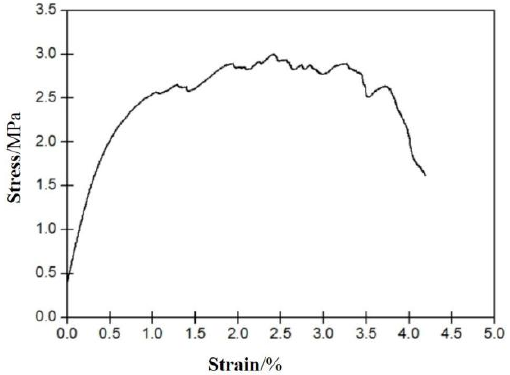
Figure 1. Stress-strain curve of ECC specimen.